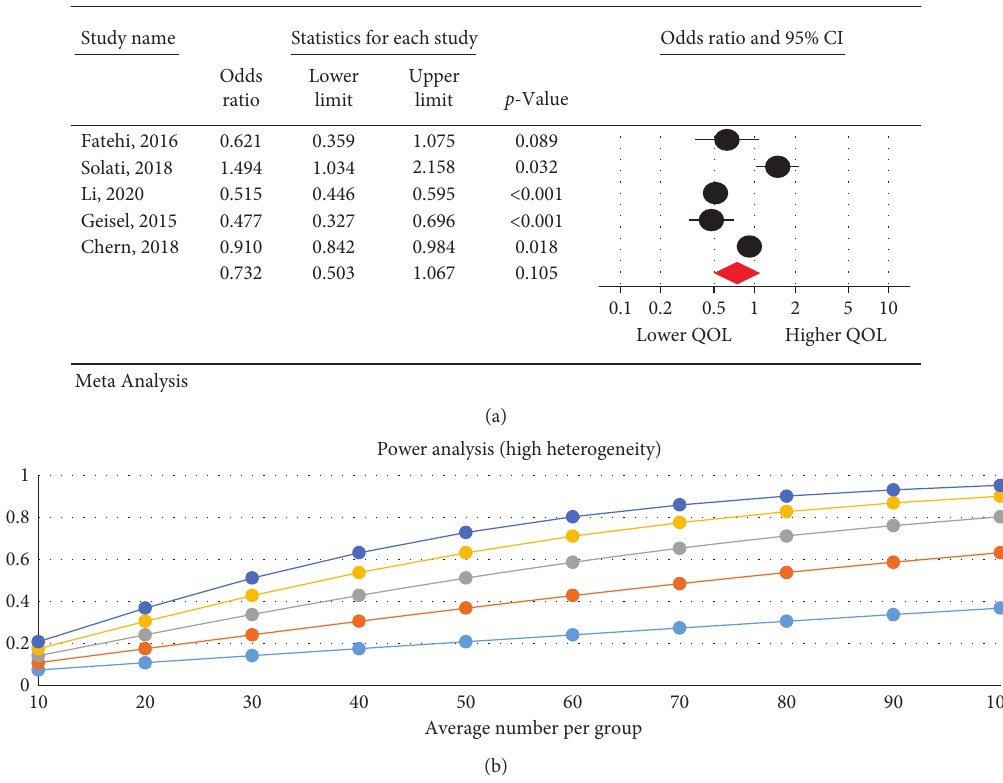
Figure 6: The relationship between the severity of internet addiction and the quality of life in the environmental dimension.